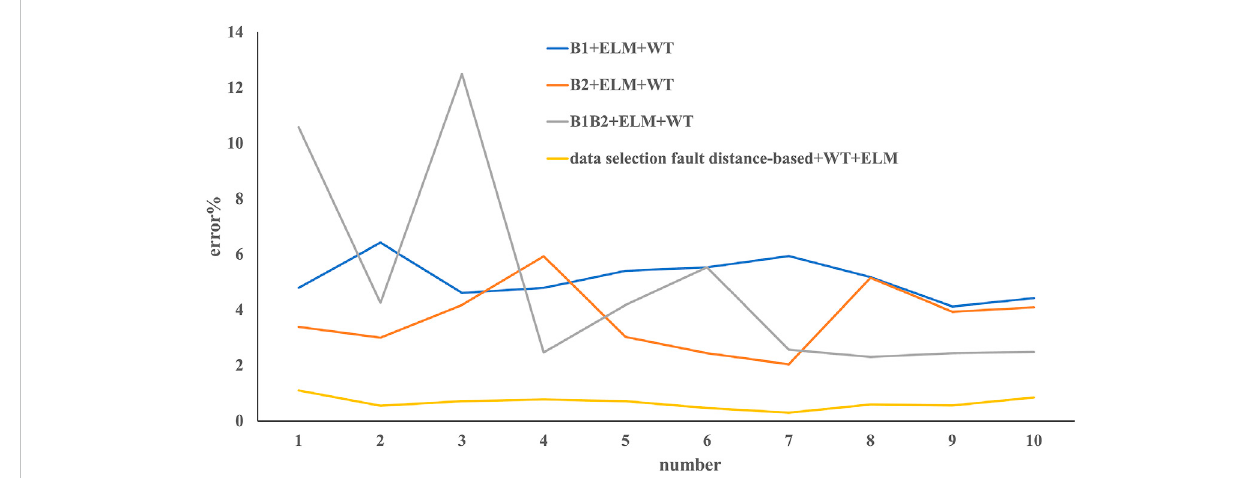
FIGURE 5 Data are located by ELM after wavelet transform.